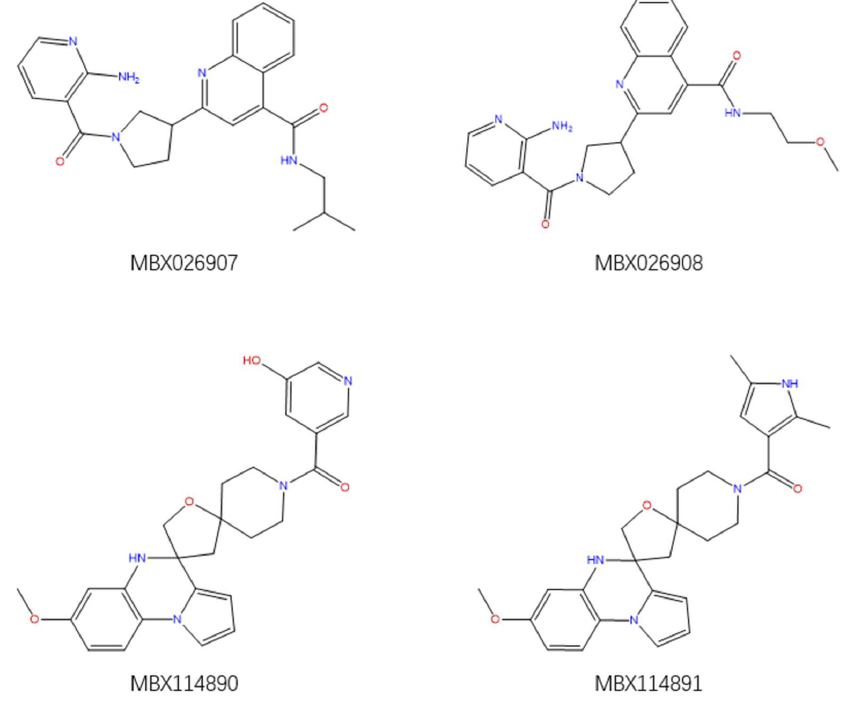
Figure 6. Partial selected molecules.